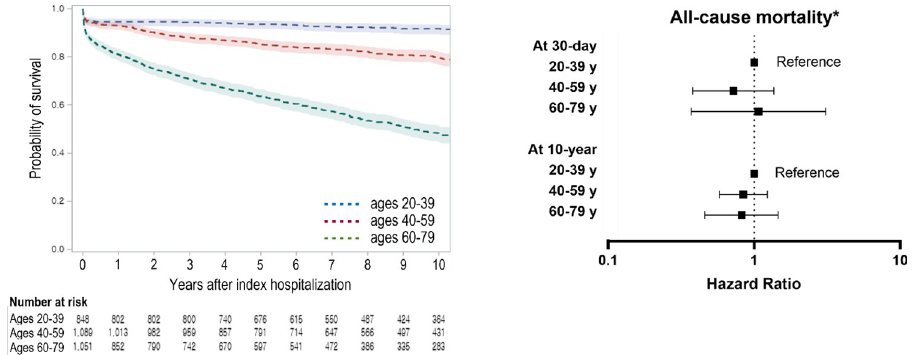
Fig 2. All-cause mortality according to differential age groups. � Adjusted for age and sex.